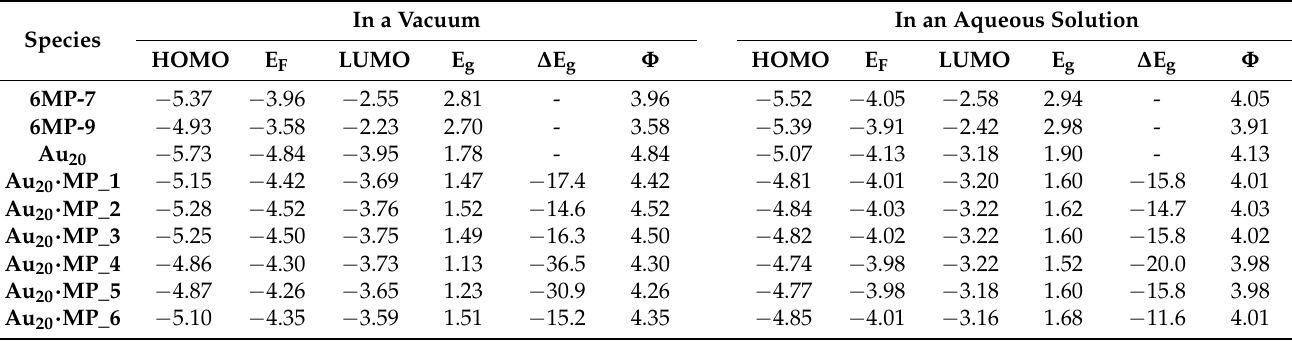
Table 2. Energies of HOMO and LUMO, Fermi level energy (E F ), work function ( Φ ), energy gap (E g and change of energy gap ( ∆ E g ) upon the 6MP adsorption on the A u20 surface. Values are given in eV, except for ∆ E g (%). In a Vacuum In an Aqueous Species